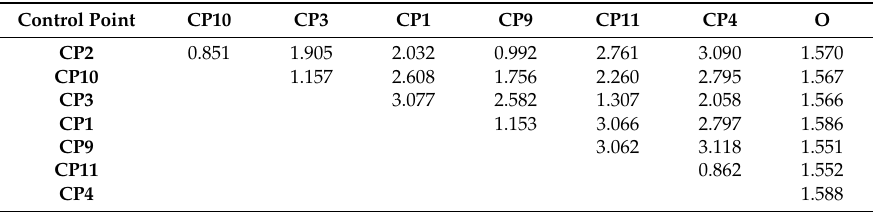
Table 3. Compensated values (units in (m)).